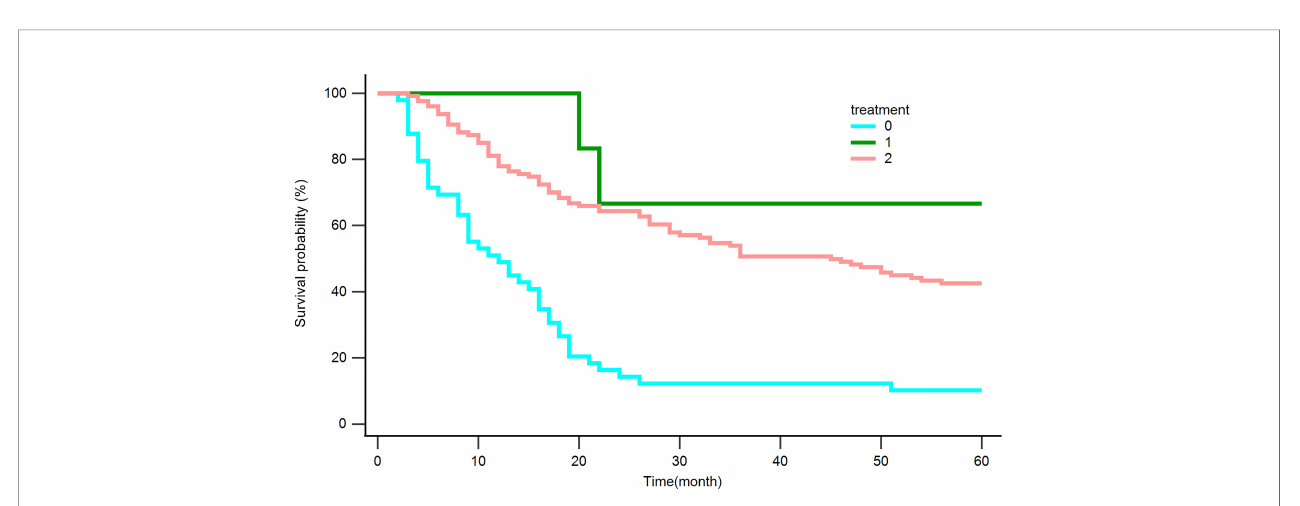
FIGURE 8 | Kaplan ‒ Meier curves for overall survival in patients with recurrence after hepatectomy. Palliative care (0), Surgery (1), Comprehensive treatment